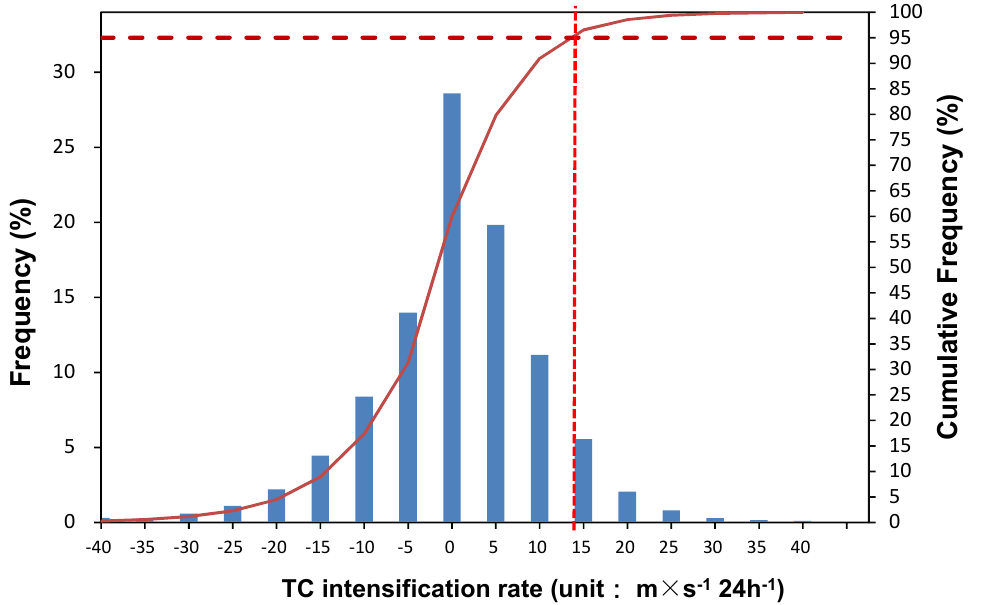
Figure 1. RI data set sample distribution map.